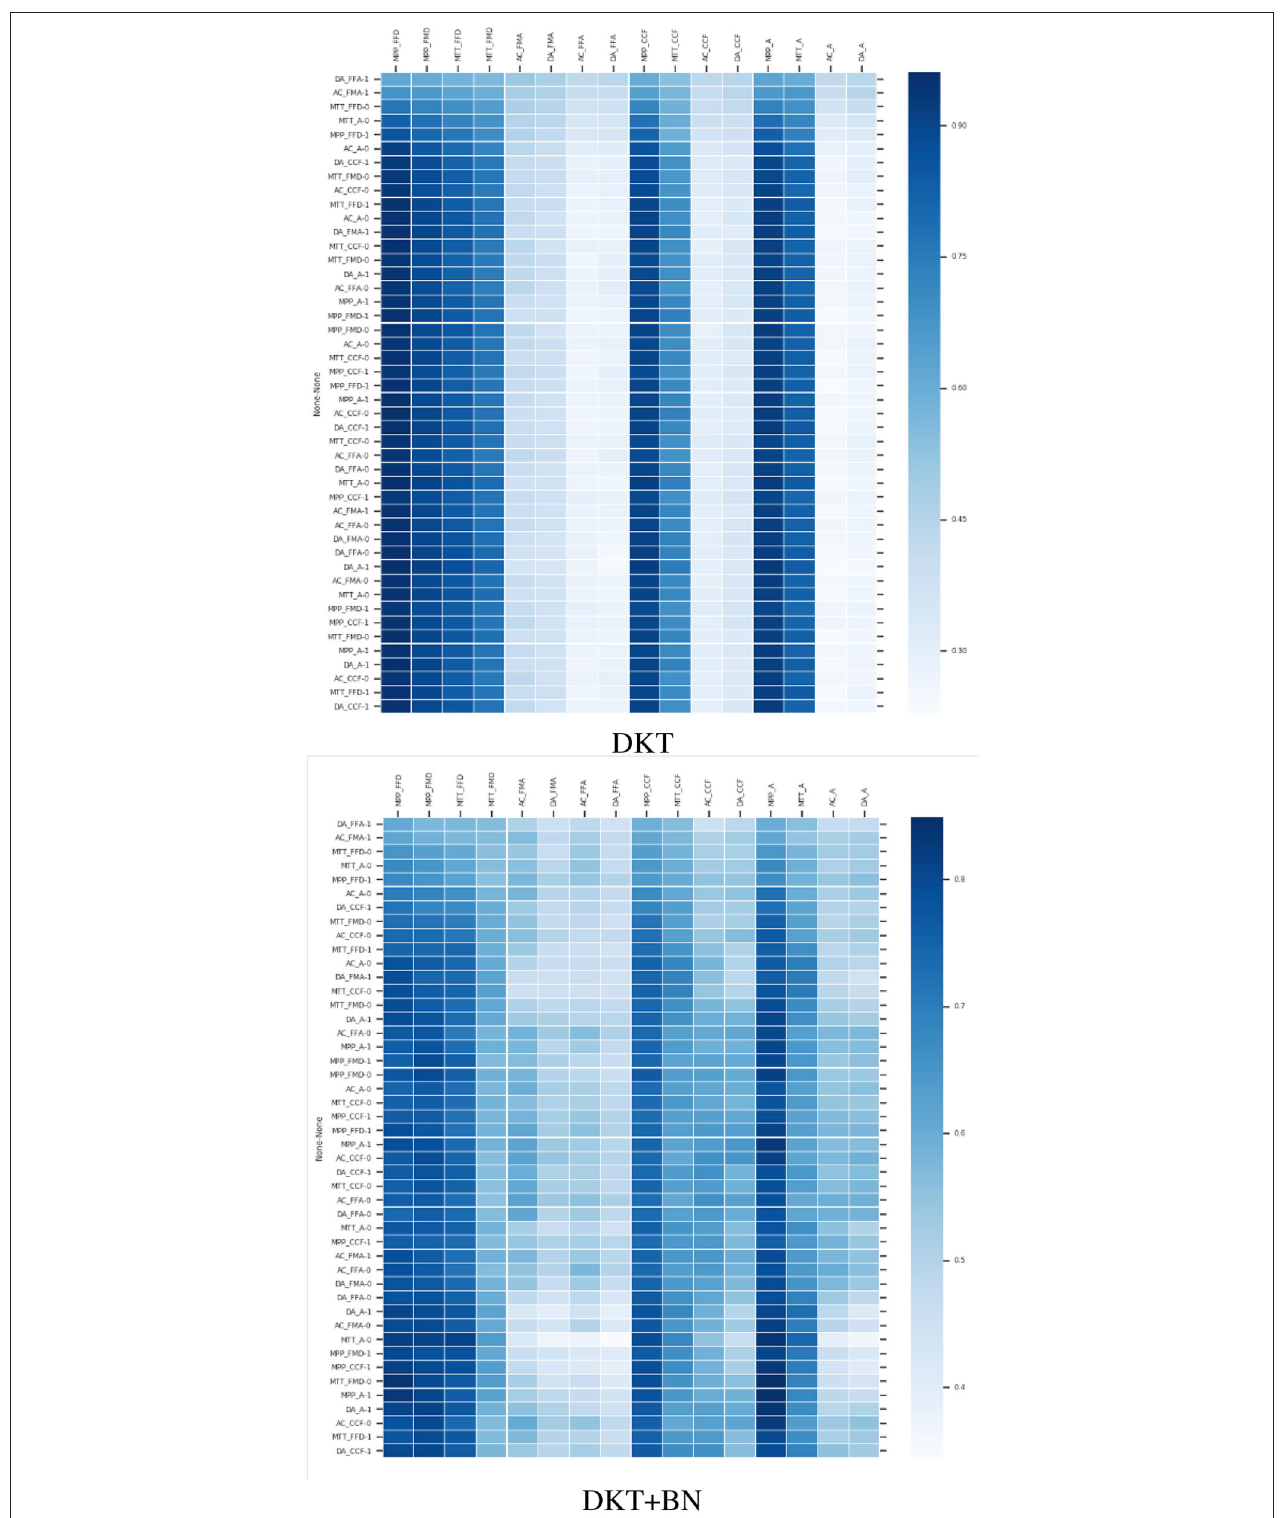
FIGURE 3 | Heatmaps illustrating the prediction with the 2 models on the same student. DKT is unable to make accurate predictions on skills with little data, especially skills that are difficult to master. The label in the vertical dimension refers to the input fed into the models at each time step. The color of the heatmap indicates the predicted probability that the student will correctly answer a question related to a skill in the next time step. The darker the color, the higher the probability. Here, the student gave 2 out of 3 correct answers on AC_FMA and we see that the DKT+BN is able to track down that information compared to the DKT.